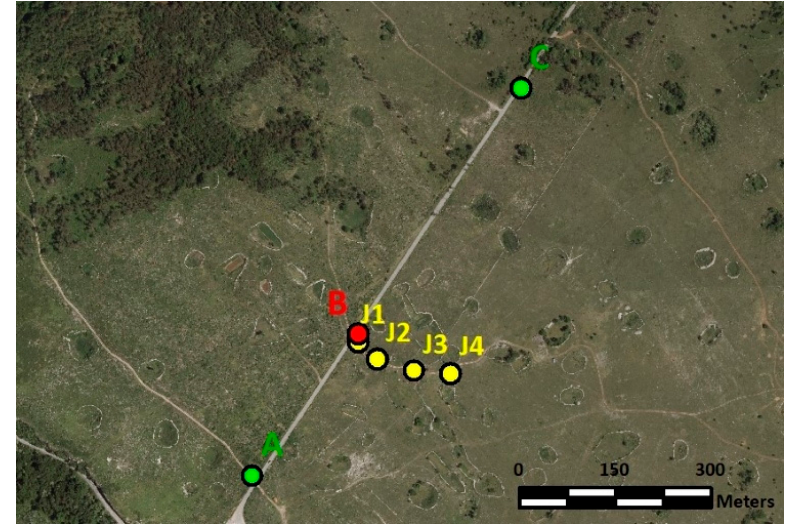
Figure 4. Pre-planned measurement scenarios (own study). GNSS: Global Navigation Satellite System.